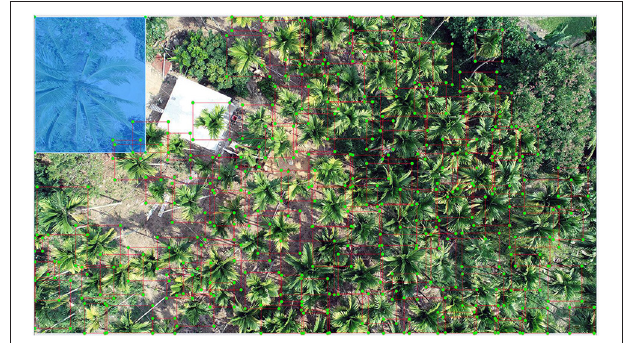
FIGURE 1 | Areca palm plantation at the experimental site labeled with red quadrates. The blue semitransparent box covers a coconut palm (part of the